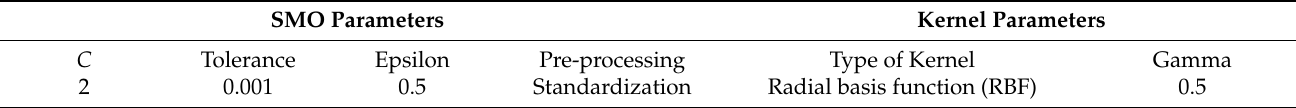
Table 4. The specifications of the best performing SVM.